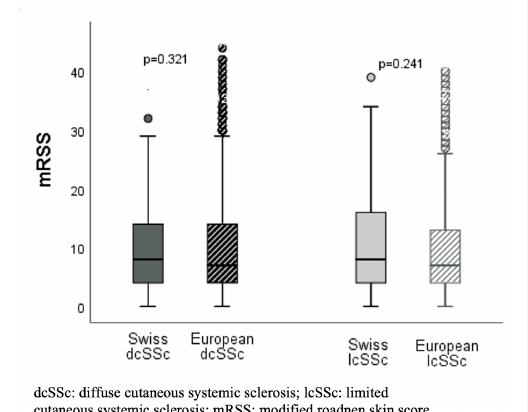
Figure 2: Skin fibrosis in Switzerland and Europe. dcSSc = diffuse cutaneous systemic sclerosis; lcSSc = limited cutaneous systemic sclerosis; mRSS = modified Rodnan skin score